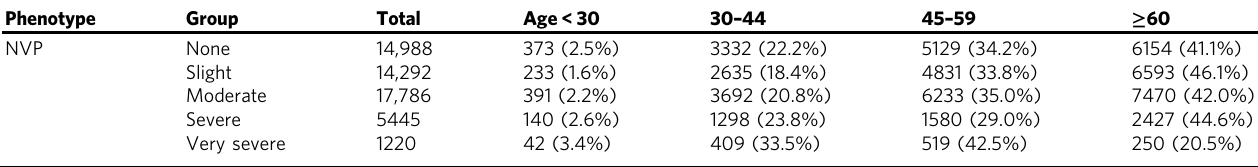
Table 3 Demographic characteristics of unrelated female individuals of European descent included in SCAN2 Phenotype